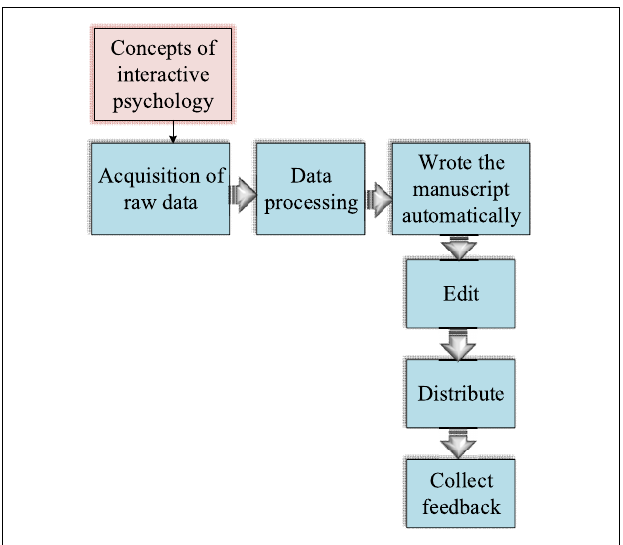
FIGURE 6 | Artificial intelligence writing process based on ID psychology.